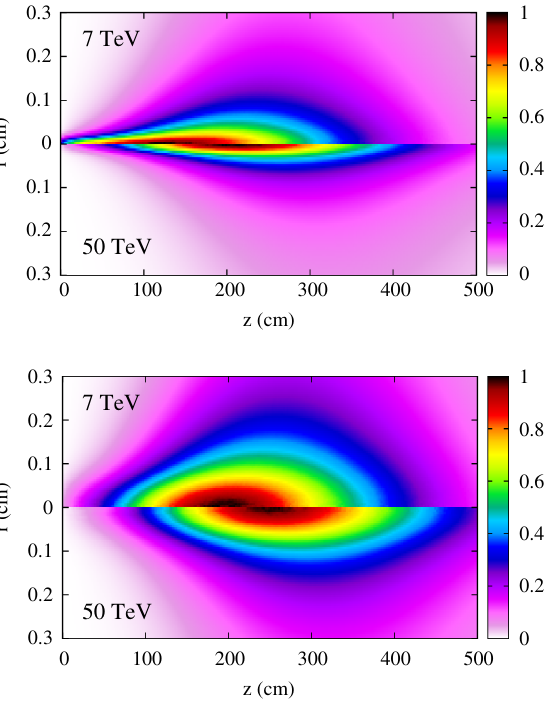
FIG. 4. Maximum energy deposition density (top) and temper- ffiffiffiffiffiffiffiffiffi p FIG. 5. Energy deposition density maps, calculated with β β ature (bottom) versus , induced by a single LHC, HL-LHC x y FLUKA, for a 7 TeV bunch (top half) and a 50 TeV bunch and FCC proton bunch in a CfC absorber with a density of (bottom half) in a CfC absorber with a density of 1 . 4 g = cm 3 . The 1 . 4 g = cm 3 . The energy densities were obtained with FLUKA beam size ( σ ) is assumed to be 100 μ m in the upper figure, and 400 μ m in the lower figure. The beam direction is from the left to simulations, assuming that beams are round ( β x ¼ β y ). The physical beam size ( σ ¼ σ x;y ) is displayed next to the data points. the right. The z -variable indicates the absorber depth and the r -variable the radial distance from the beam axis. All maps are The FCC bunch parameters are specified in Table I. The LHC and expressed as a fraction of the maximum energy deposition HL-LHC beam parameters are detailed in the text.